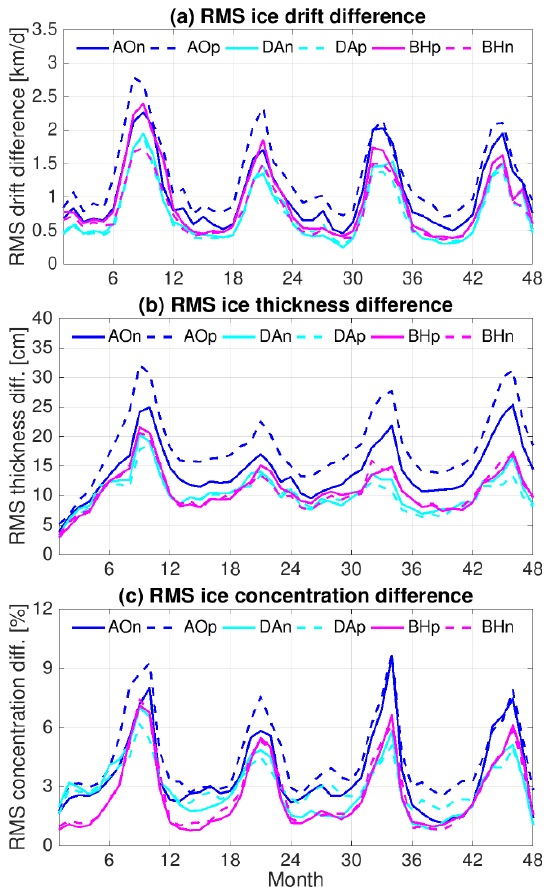
Figure 9. Monthly root-mean-square (rms) difference of (a) sea ice drift speed, (b) thickness and (c) concentration between runs with perturbed initial ocean and the control run. The rms difference is calculated where sea ice concentration is larger than 20% in both the simulations that are